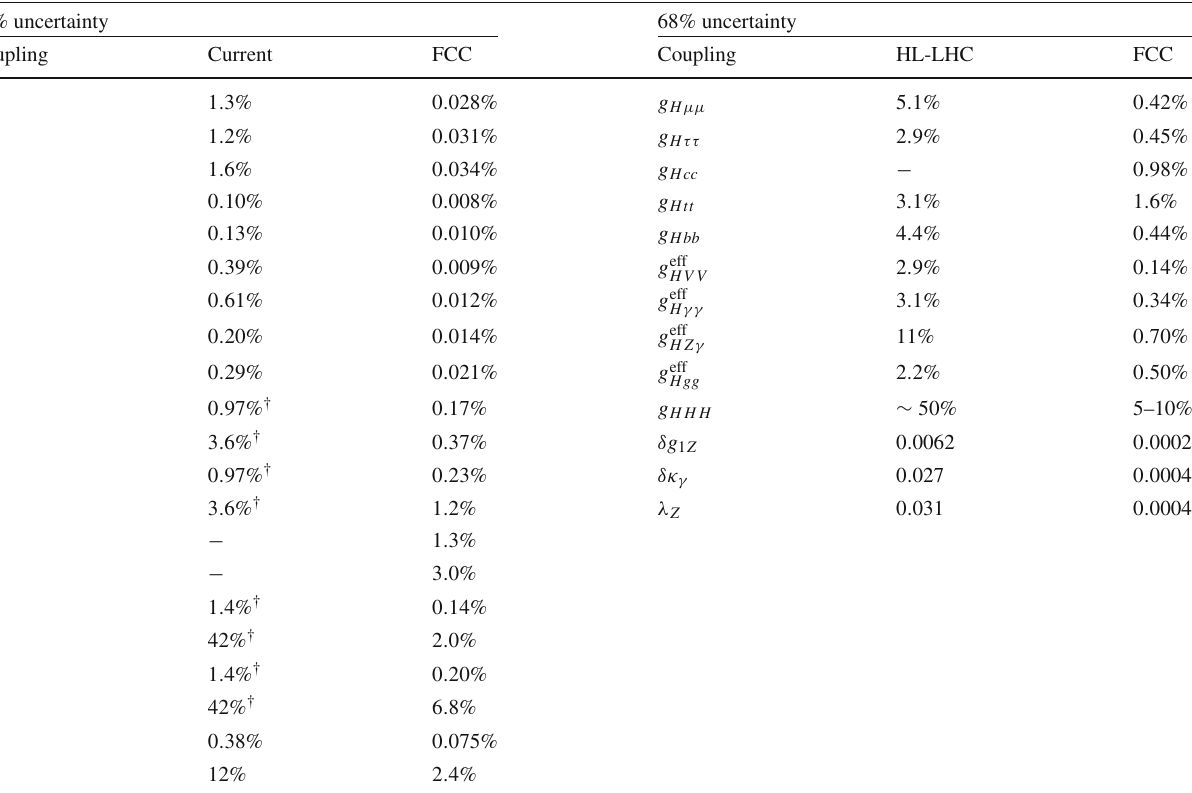
Table 8.2 Summary table of the results presented in this section for the precisions of the EW and Higgs couplings and aTGC parameters obtained from the EFT fit to the different observables at FCC. The numbers correspond to the 68% uncertainties on the various parameters, computed from the posterior distributions obtained from the global fit. The results assume that theory uncertainties due to missing higher-order calculations of the SM predictions will become negligible compared to the experimental precision. Numbers indicated by a † are obtained assuming partial fermion universality for the first two families of quarks. The FCC reach is compared with that from current LEP constraints (see Fig. 8.2) as well as the HL-LHC projections shown in Fig.